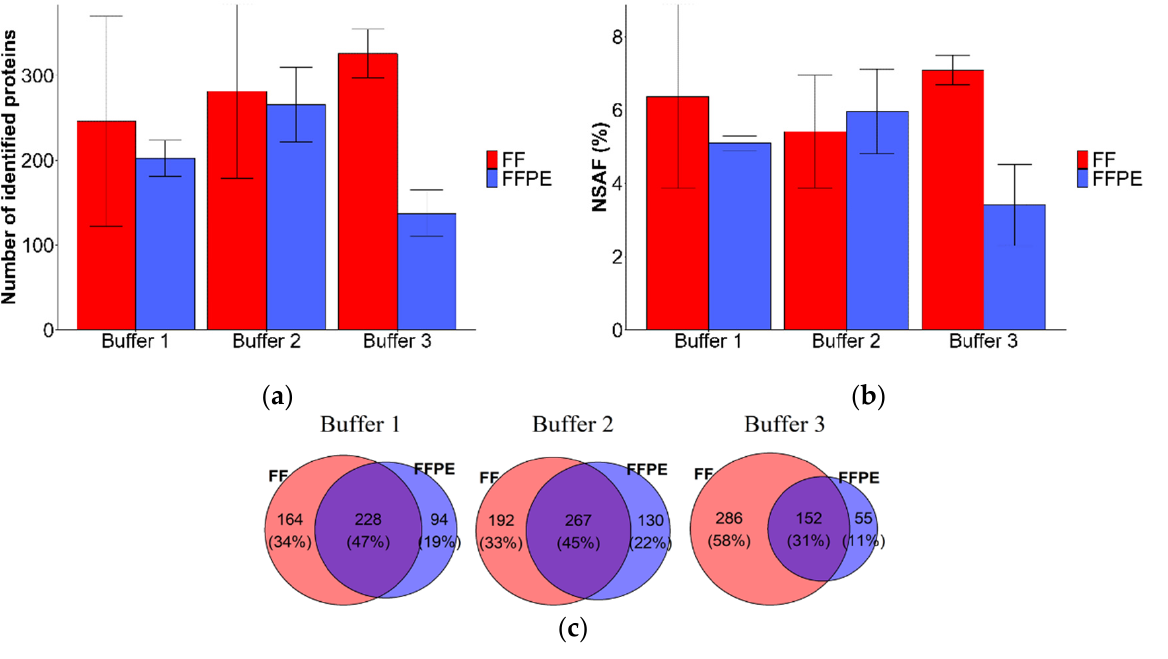
Figure 3. Qualitative and quantitative comparison of 4 μ m thick FF and FFPE tissue. ( a ) Number of identified proteins for 4 μ m thick FF and FFPE kidney tissue with Buffers 1 to 3. ( b ) Quantitative comparison of protein abundance by total NSAF values for 4 μ m thick FF and FFPE tissue after extraction with Buffers 1 to 3. NSAF values were expressed as a percentage of all proteins in all samples of all buffers. ( c ) Venn diagrams illustrating distribution of identified proteins between 4 μ m thick FF (red) and FFPE (blue) tissue samples for Buffers 1 to 3. Results are shown as mean ± SD.